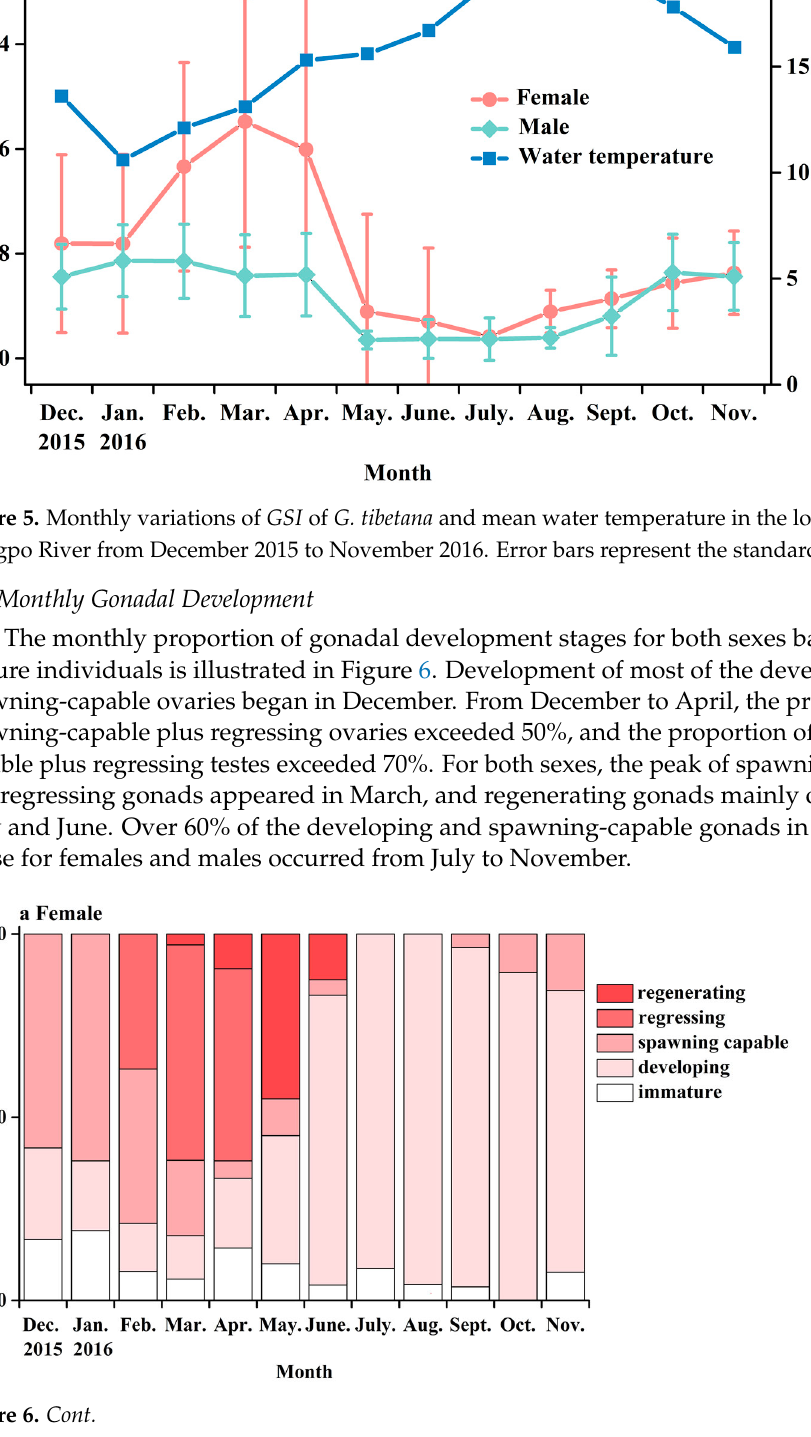
Figure 6. Monthly proportion distribution of gonadal development stages of mature individuals for females (( a ), standard length > 82.4 mm) and males (( b ), standard length > 55.4 mm) of G. tibetana in the lower Yarlung Tsangpo River from December 2015 to November 2016 3.6. Frequency Distribution of Oocyte Diameter A total of 89 mature ovaries from samples collected from December 2015 to April 2016 were subsampled for oocyte ‐ diameter distribution analysis. During the spawning season of G. tibetana , the oocyte ‐ diameter distribution always had one peak ranging from 1.7 mm to 3.5 mm. This distribution pattern indicated that a majority of oocytes matured and were spawned synchronously. The median oocyte diameter increased continually from 2.5 mm in November to 2.9 mm in April with significant inter ‐ monthly differences (Figure 7, ANOVA, Tukey’s post hoc, p < 0.05), which approximately coincided with the monthly variation of the GSI and gonad development.